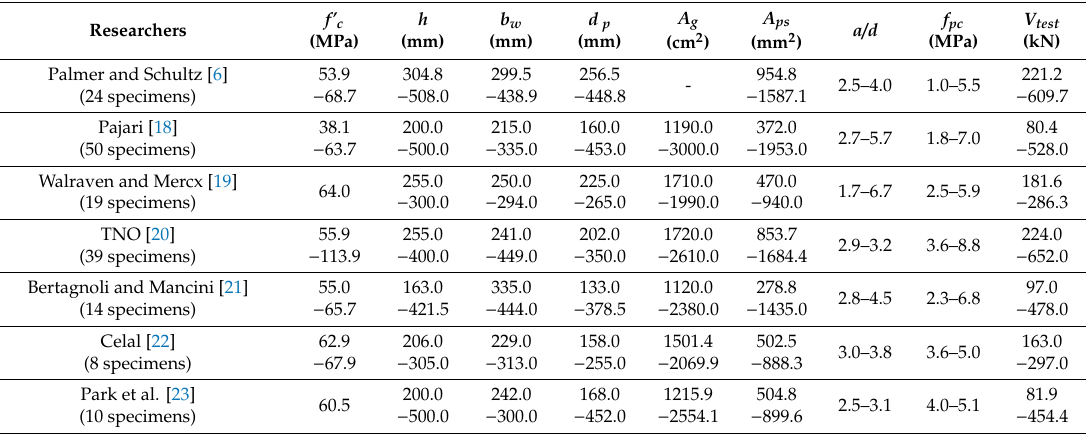
Table 4. Summary of previous studies.